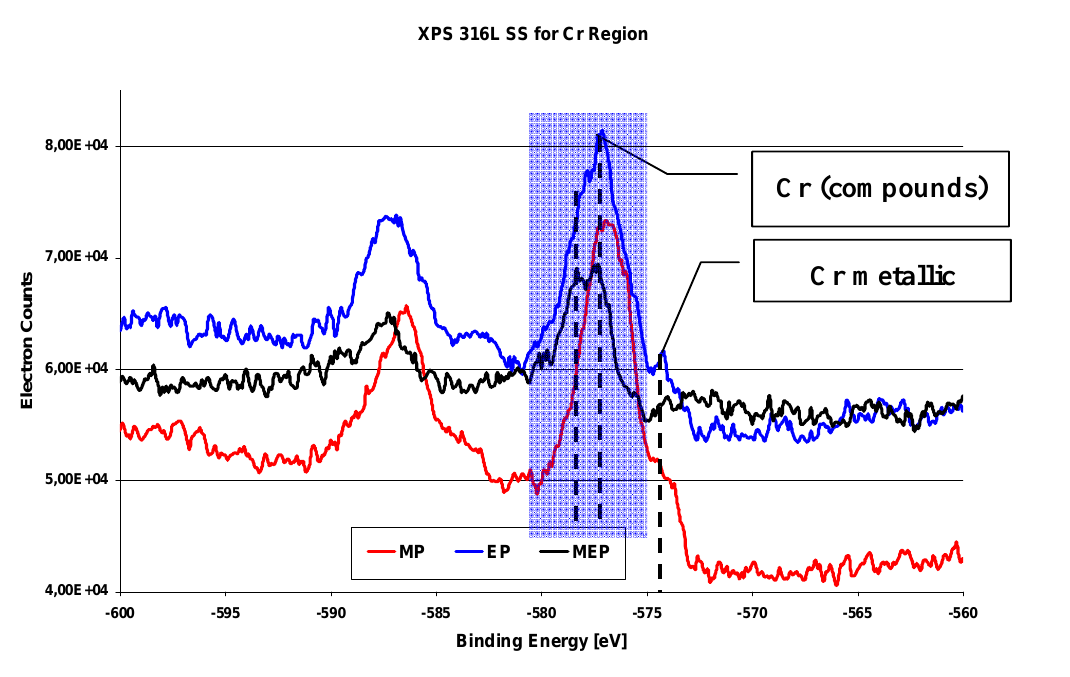
Figure 10. XPS results for Cr region of 316L SS surfaces after: MP – abrasive polishing, EP – standard electrolytic polishing, and MEP – magnetoelectropolishing